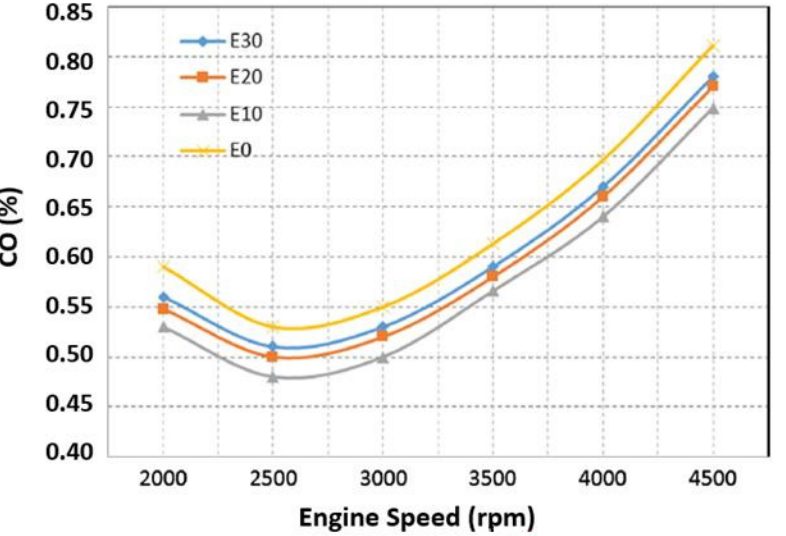
Figure 3. Variation in CO emissions with different engine speed and ethanol content in the blends: comparison between gasoline (E0), 10% ethanol v / v (E10), 20% ethanol v / v (E20) and 30% ethanol v / v (E30) [92]. Reproduced with permission from Applied Thermal Engineering; published by Elsevier, 2017. License Number: